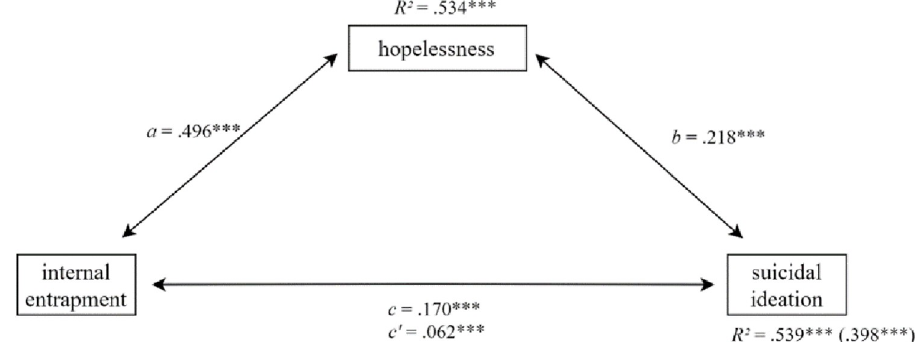
Fig 1. Mediation model 1 with internal entrapment as predictor.